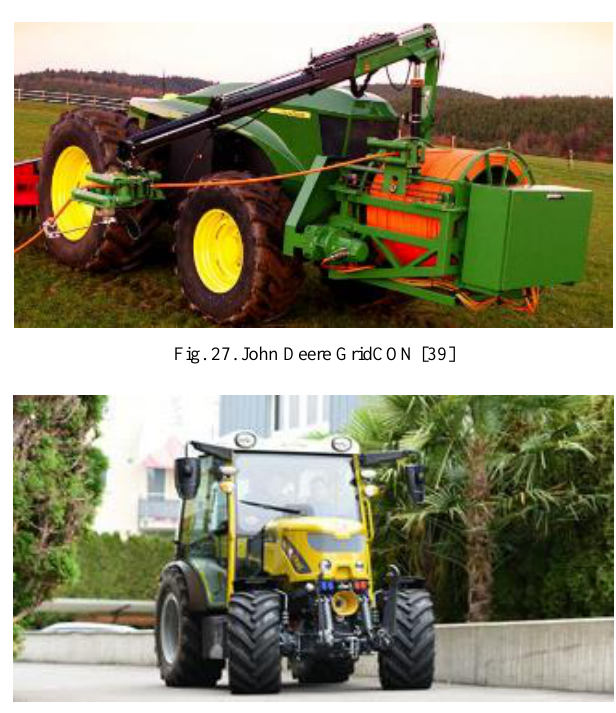
Fig. 28. Rigitrac SKE50 [41]